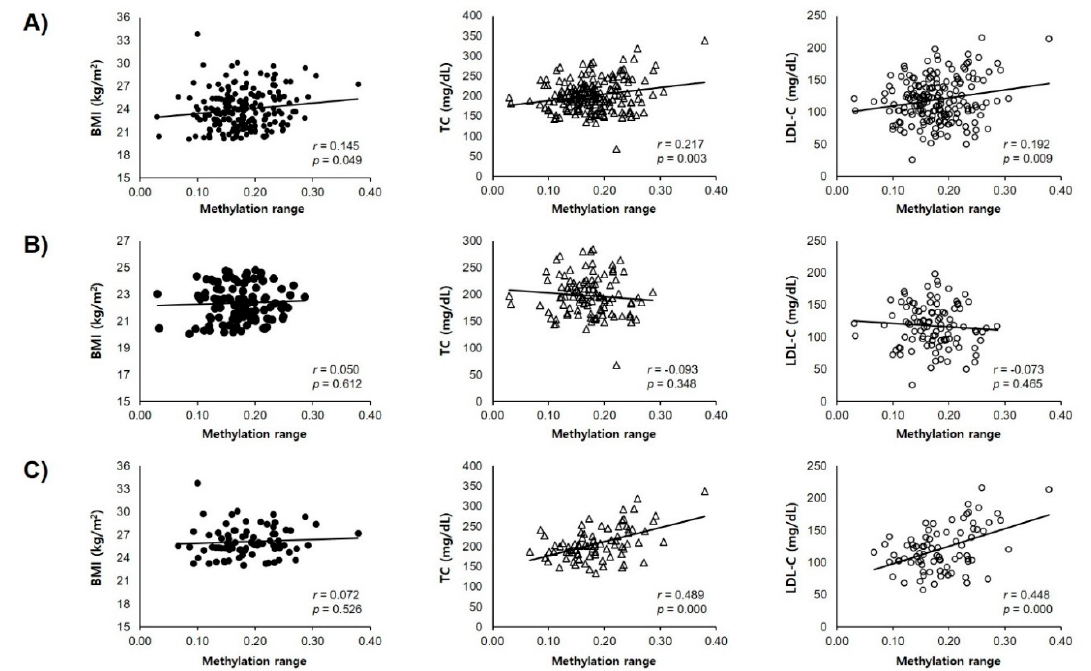
Figure 2. TSPOAP1-AS1 methylation associated with obesity. ( A ) Distribution of mean DNA methylation level on normal and overweight / obese subjects. ( B ) Significance of hypermethylation at the specific CpG sites of TSPOAP1-AS1 promoter region in overweight / obese subjects compared to normal subjects.